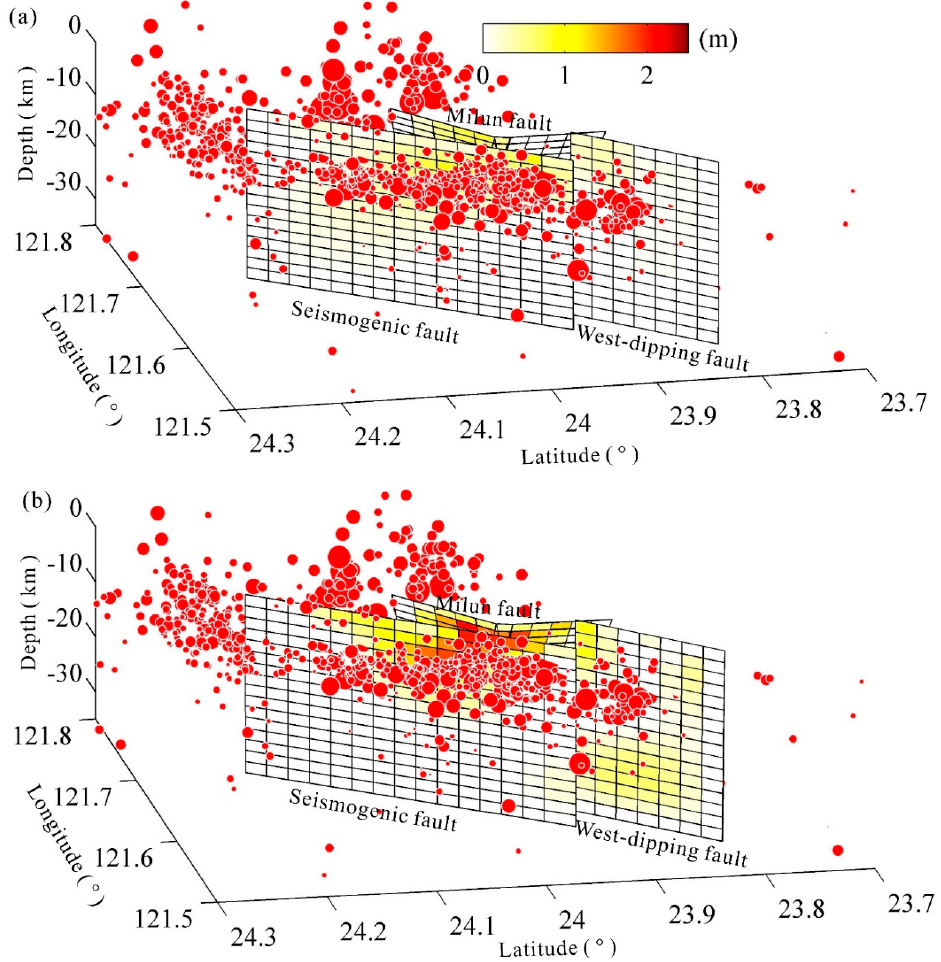
Figure 4. The faulting models respectively inferred by GPS and InSAR observations, and the red dots are the aftershocks of the 2018 Hualien earthquake. ( a ) The co-seismic faulting model inferred by GPS displacements with a peak slip of ca. 0.9 m. ( b ) The co-seismic and postseismic faulting model of the 2018 Hualien earthquake, in which the maximum accumulated slip magnitude is up to ca. 2.1 m.